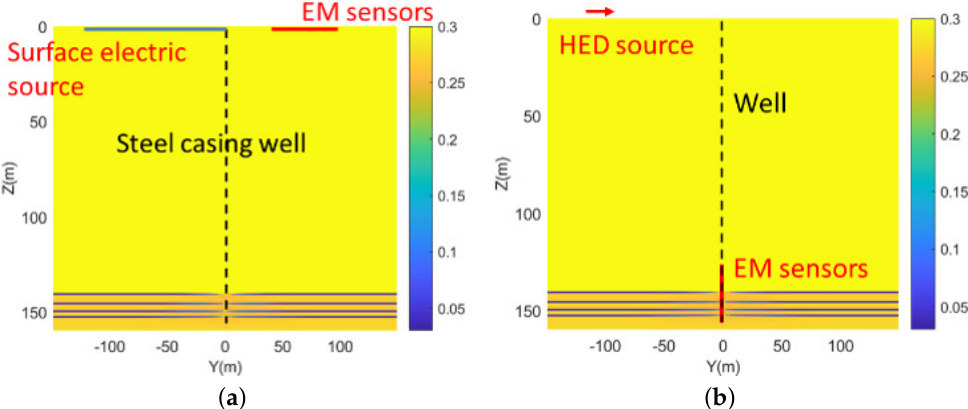
Figure 12. EM survey configuration: ( a ) the surface-to-surface monitoring, ( b ) the surface-to-borehole monitoring. Each legend bar represents the electrical conductivity (unit: